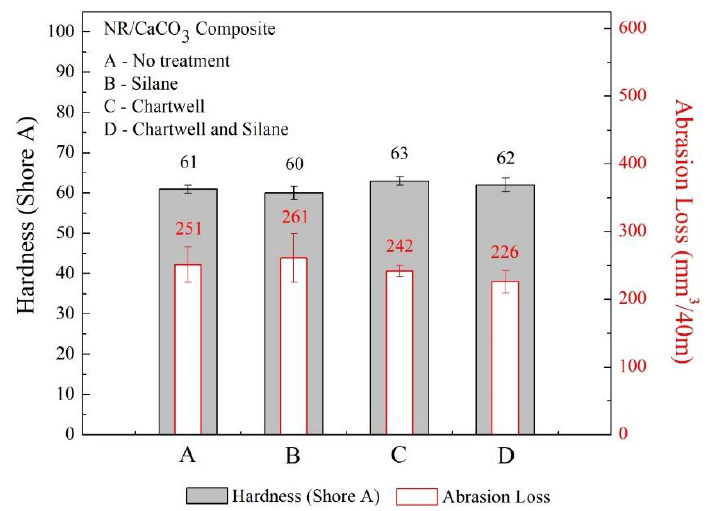
Figure 5. Shore A hardness of the NR composites with 40 phr of calcium carbonate (CaCO 3 ) measured with a Kiltler durometer and their loss of volume by abrasion measured with a rotating drum with a diameter of 150 mm at a frequency of 40 rpm and a nominal distance of 40 m. Only the coupling agents were changed.